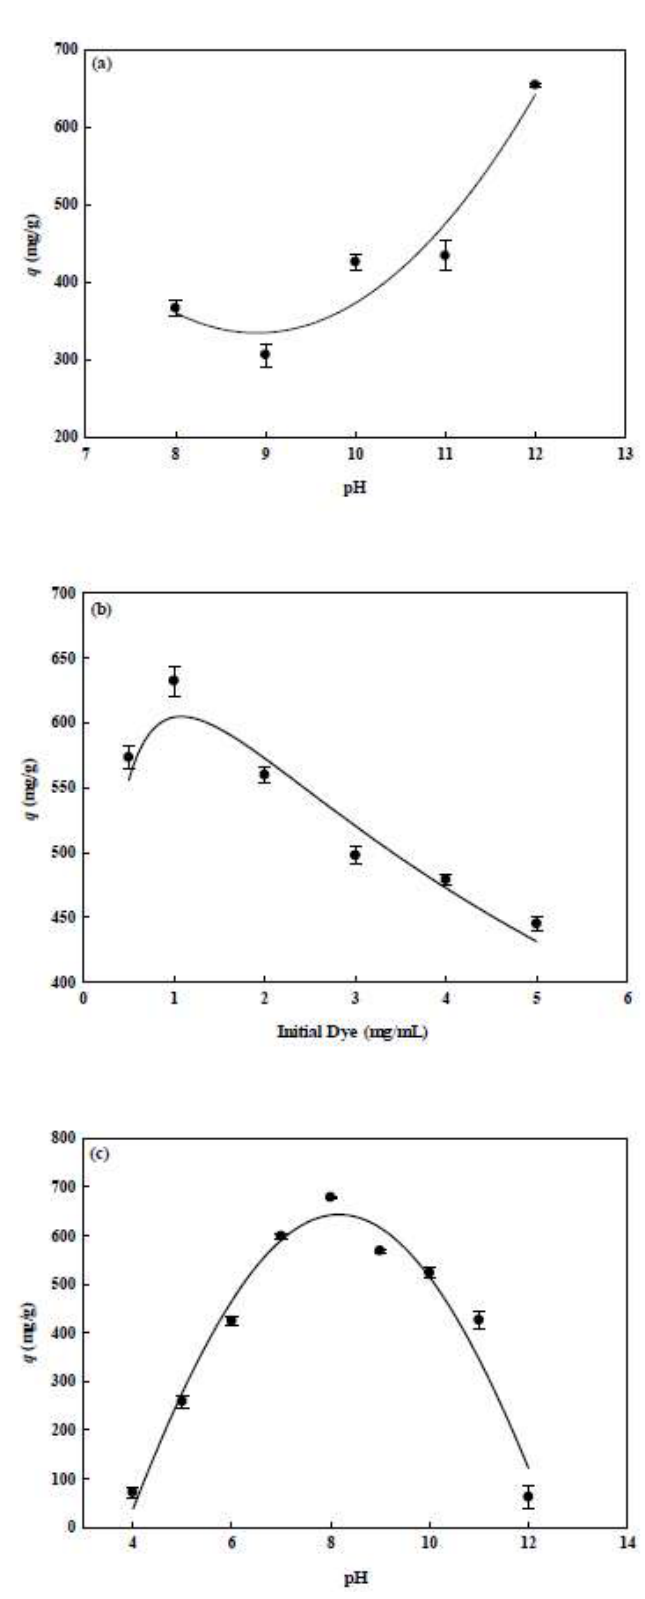
Figure 6. The effect of ( a ) dye solution pH, ( b ) initial dye concentration, and ( c ) lysozyme adsorption pH on the adsorption capacity for lysozyme.